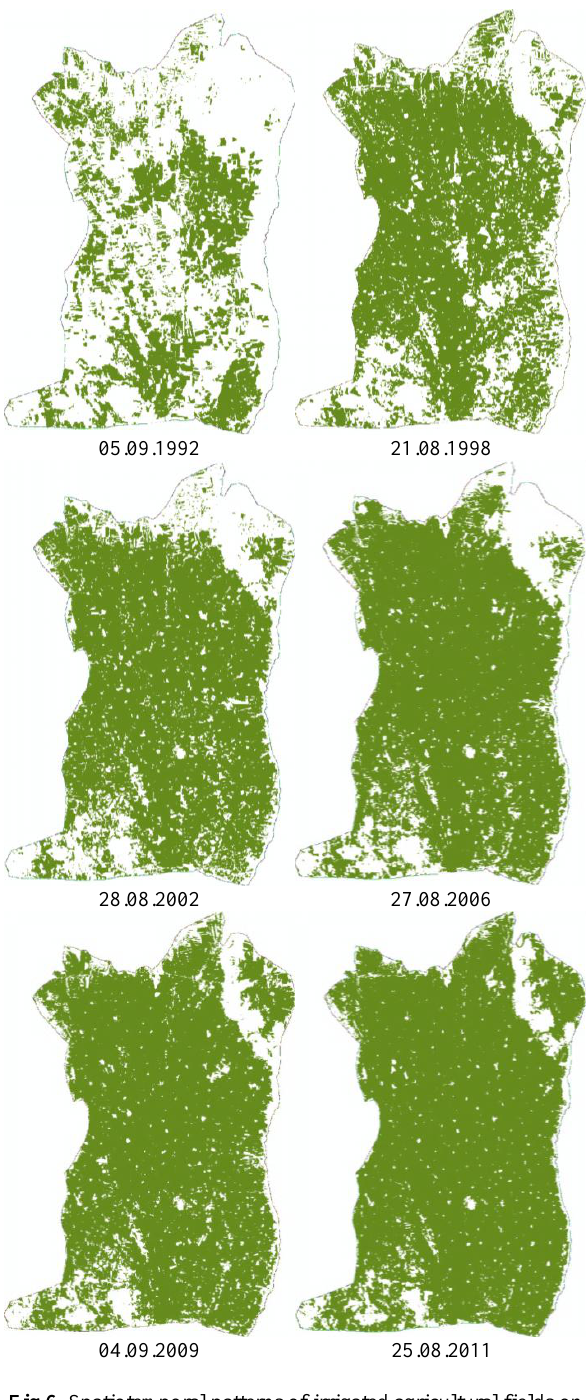
Fig 6. Spatiotemporal patterns of irrigated agricultural fields on Harran Plain within the mid to late summer times of 1992, 1998, 2002, 2006, 2009 and 2011. The figure shows an outline of the Harran Plains where green colors denote irrigated agricultural